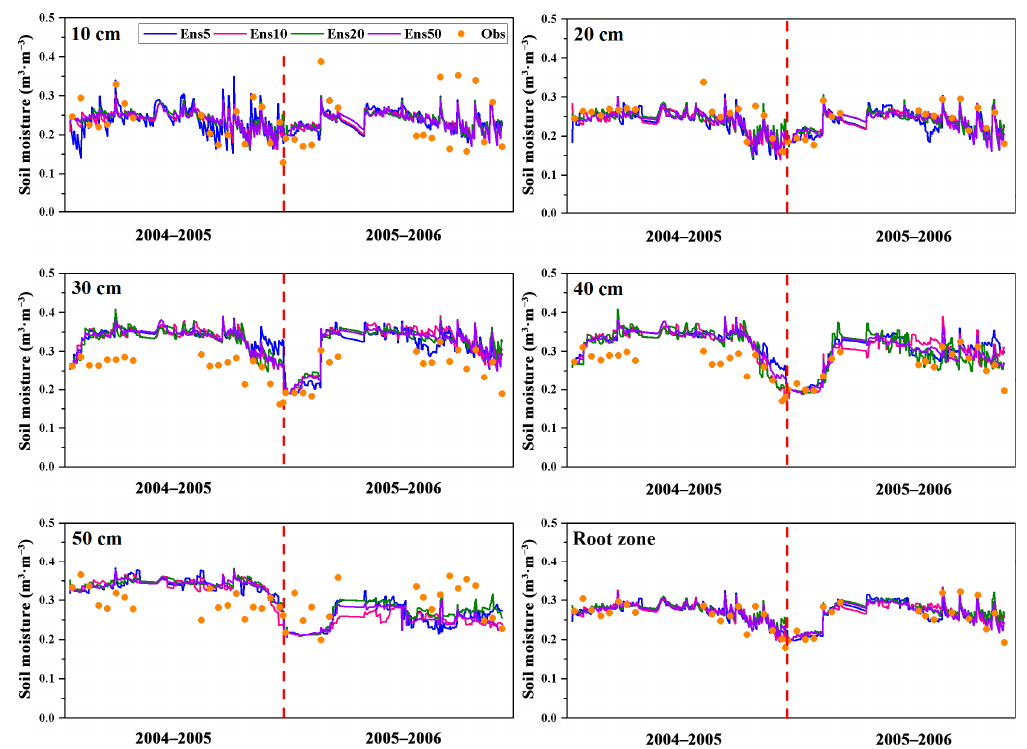
Figure 6. Soil moisture assimilation estimates with different ensemble sizes at different soil depths during the growing seasons of 2004–2005 and 2005–2006.